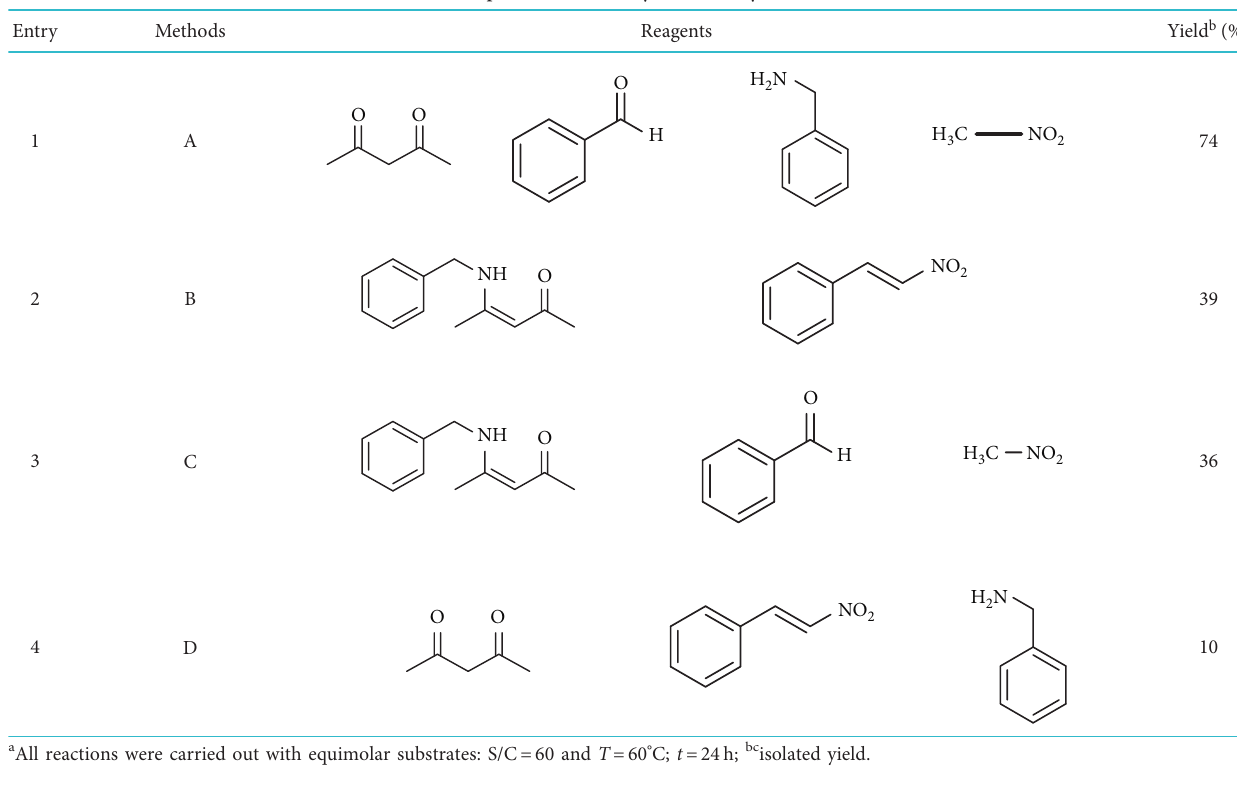
Table 1: Preparation of 1a a by the four synthesis routes.